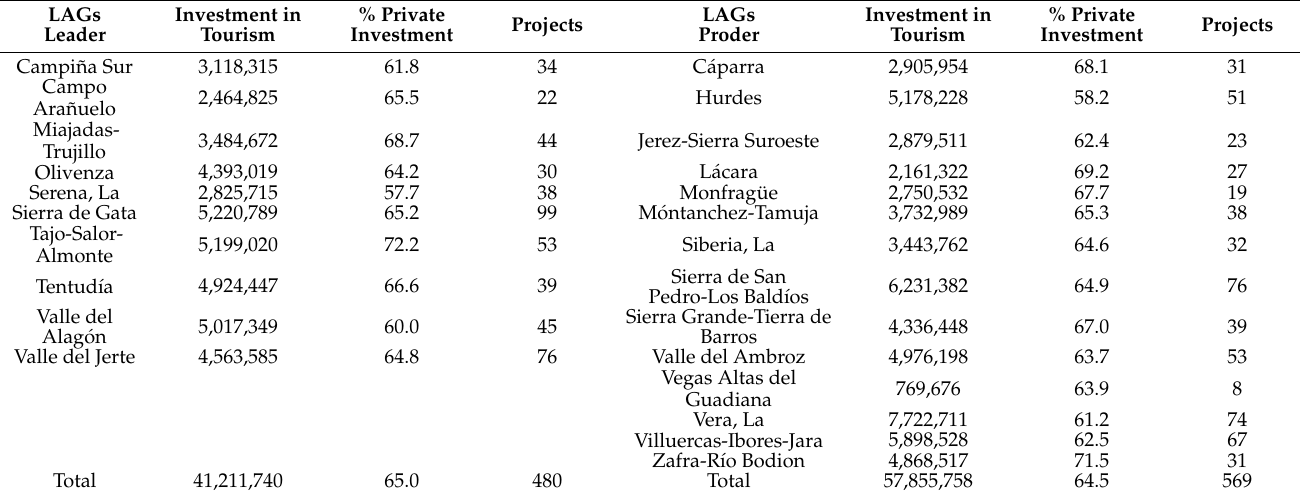
Table 2. Projects and investment in